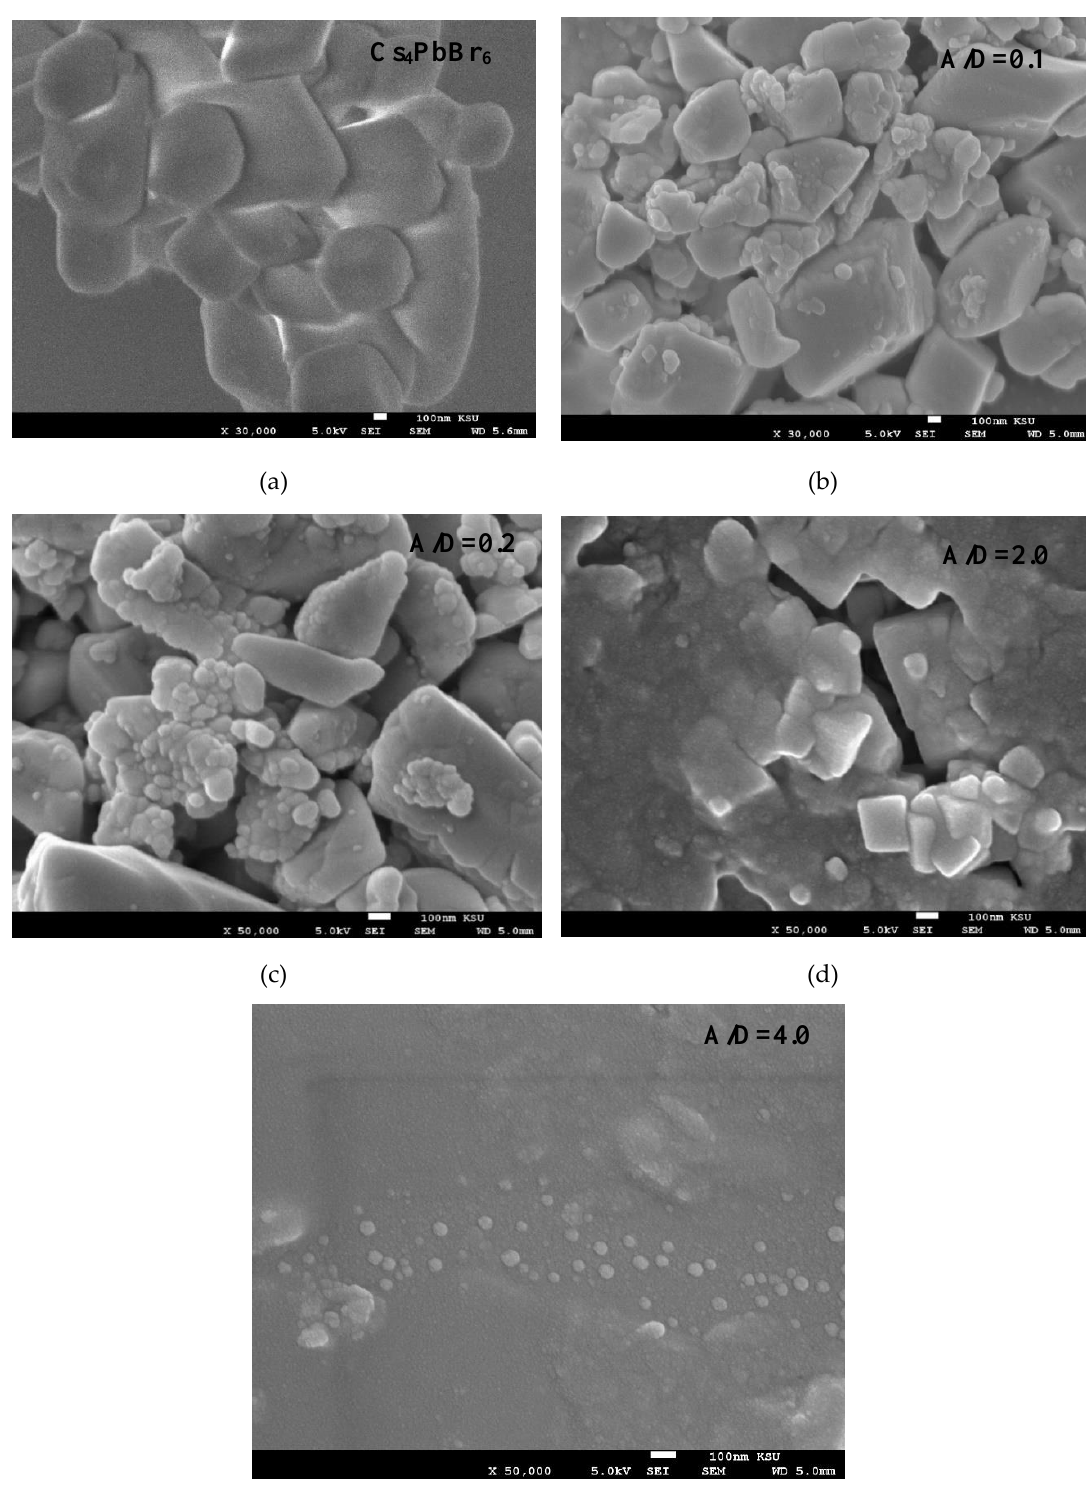
Figure 2. SEM images of the pristine 0-D Cs 4 PbBr 6 and Cs 4 PbBr 6 /MEH-PPV hybrid thin films with various ratios. ( a ) pristine 0-D Cs 4 PbBr 6 ; ( b ) 0.1 ; ( c ) 0.2 ; ( d ) 2.0 ; ( e ) 4.0.